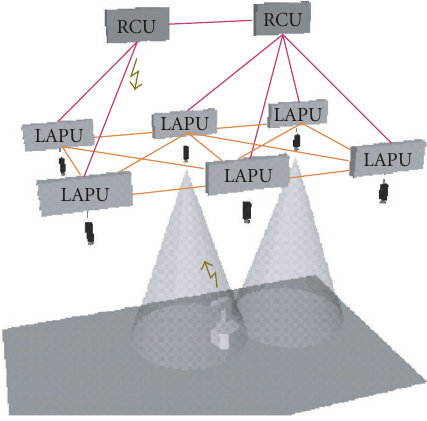
Figure 1: Distributed structure of the navigation system.